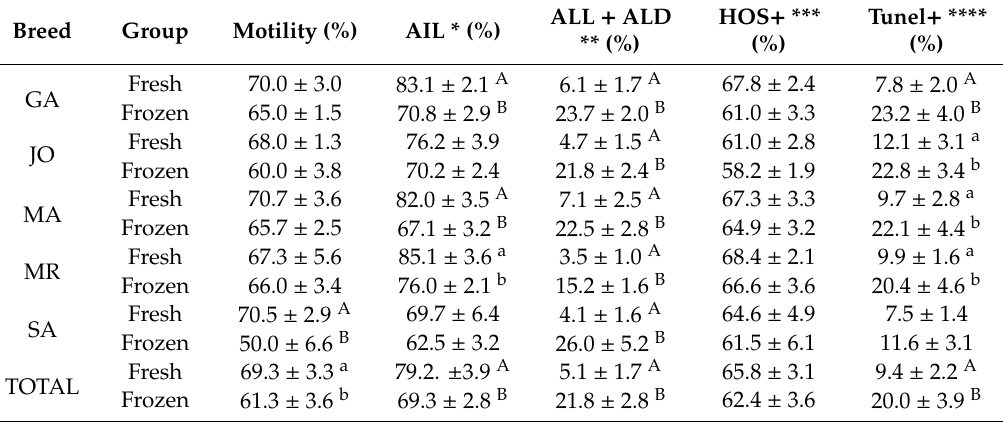
A,B Values within rows for each breed with di ff erent superscripts are di ff erent; p < 0.01. a,b Values within rows with di ff erent superscripts are di ff erent; p < 0.05. * AIL = acrosome intact live; ** ALL = acrosome loss